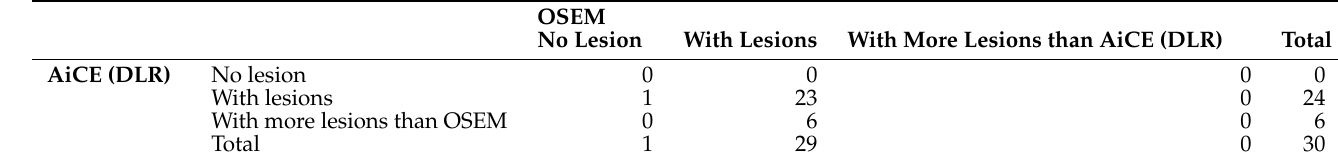
Table 5. Comparison of lesion detection capability. OSEM No Lesion With